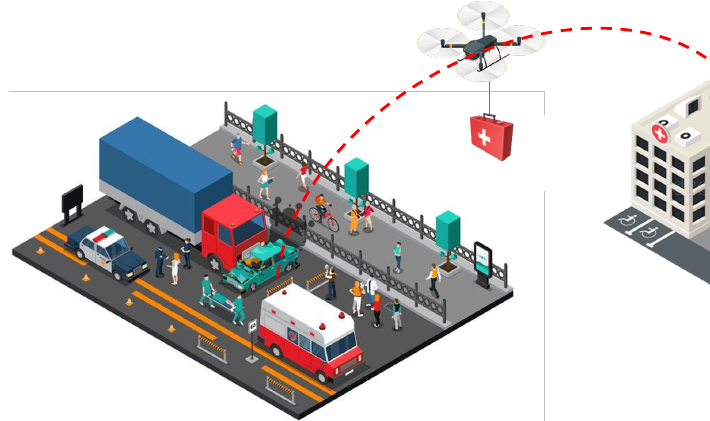
Figure 1. Example of situation of emergency delivery.